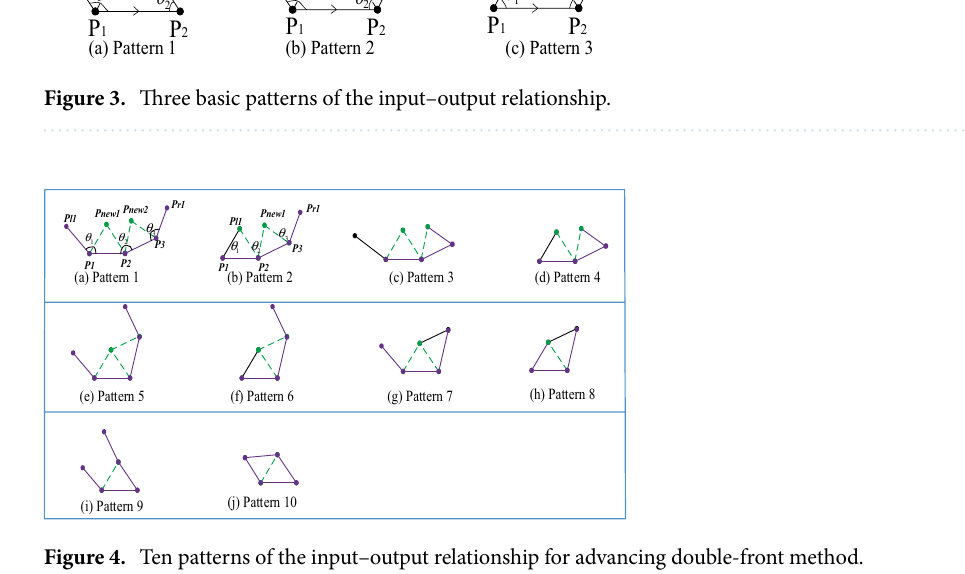
Figure 4. Ten patterns of the input–output relationship for advancing double-front